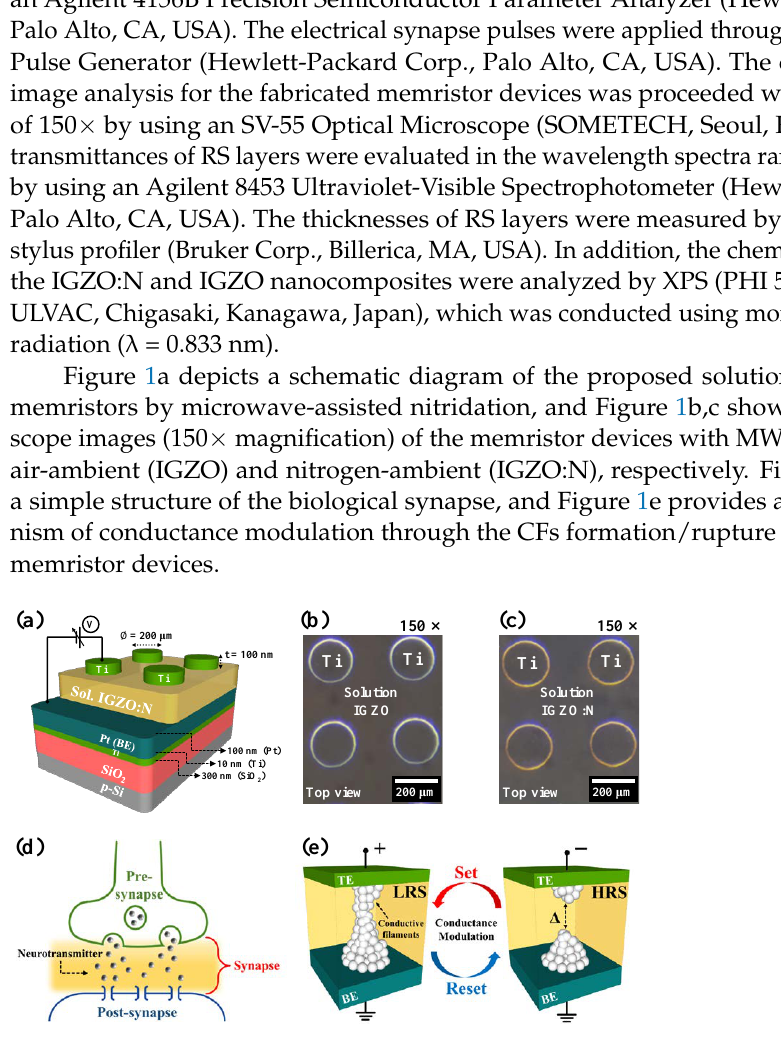
Figure 1. ( a ) Schematic diagram of proposed solution-derived IGZO:N memristors by microwave-assisted nitridation. Optical microscope images (150× magnification) of the memristor devices with MWA treated under an ( b ) air-ambient (IGZO) and ( c ) nitrogen-ambient (IGZO:N). ( d ) Simple structure of the biological synapse. ( e ) Simplified mechanism of conductance modulation through the CFs formation/rupture process.